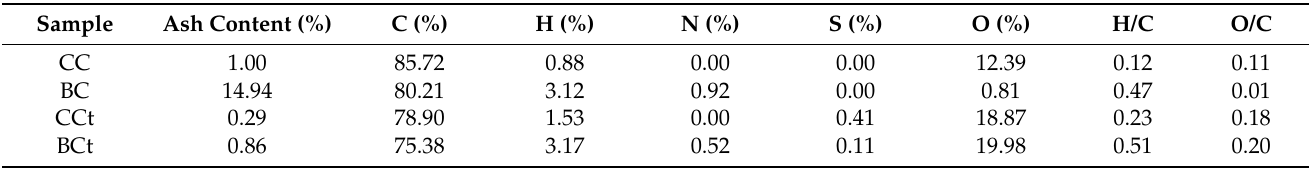
Table 2. Main properties of carbon materials (CC and BC) and carbon materials after treatment with leaching solution (CCt and BCt).